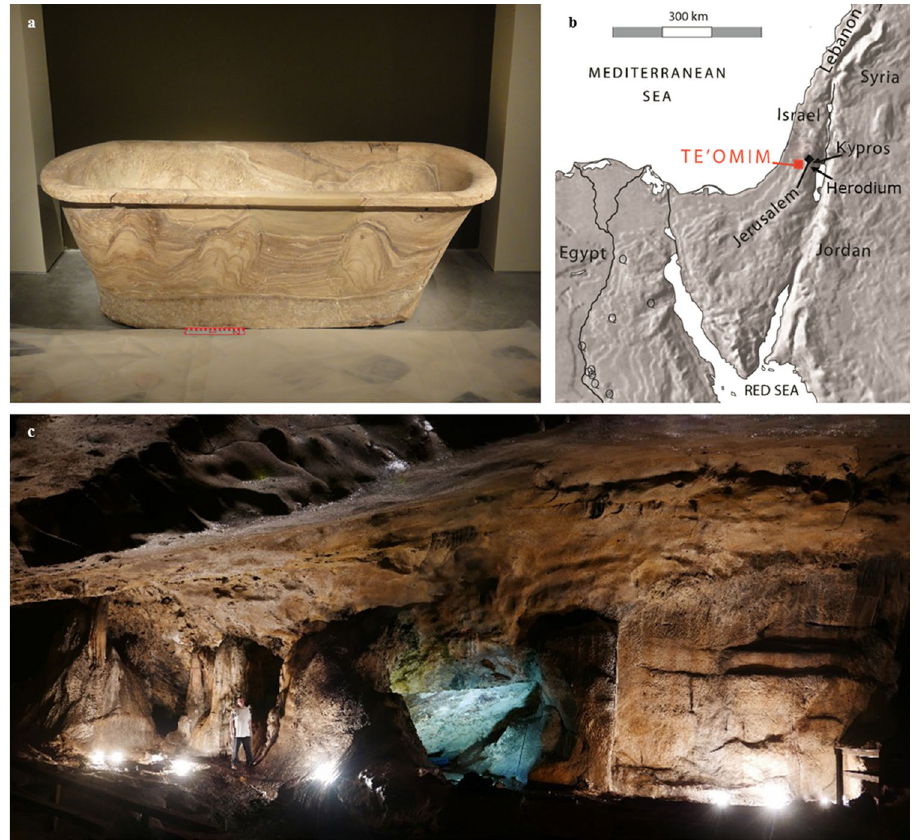
Figure 1. Calcite-alabaster in Israel. ( a ) Herod’s calcite-alabaster bathtub found in Kypros fortress. Modified after ref. 15. ( b ) Location map. The quarry and royal bathtubs studied here are at Te’omim cave, kypros and Herodium. Q indicates calcite-alabaster quarries in Egypt. Modified after ref. 15. ( c ) Te’omim cave. The quarry is located in the right part of the photograph. Photographed by Ayala Amir, Martin (Szusz) Department of Land of Israel Studies and Archaeology, Bar-Ilan